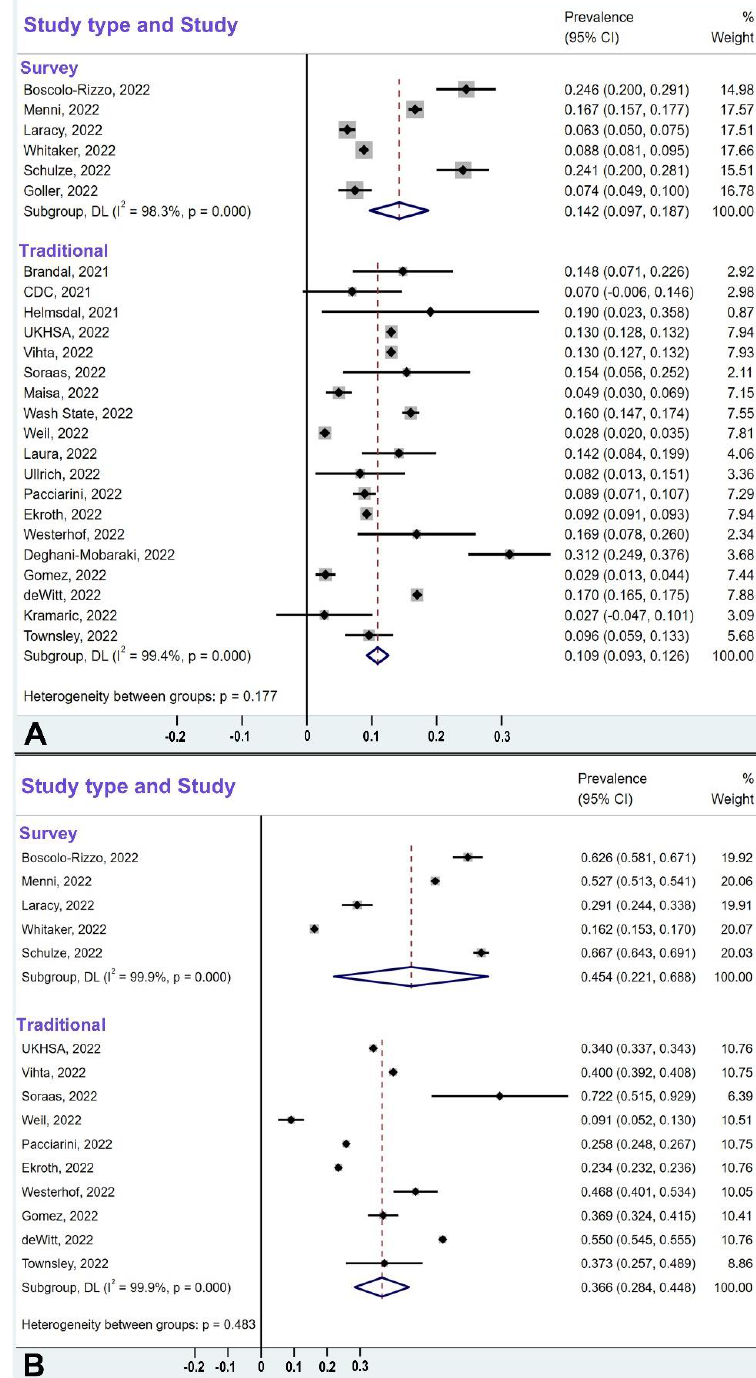
Figure 8. The pooled prevalence levels of olfactory dysfunction due to omicron ( A ) and due to other variants ( B ) in survey-type studies and traditional-design studies for populations of European ancestry. While the pooled estimates are higher in the survey-type studies than in the traditional- design studies, namely, 14.2% vs. 10.9% for omicron studies ( A ) and 45.4% vs. 36.6% for previous variants ( B ), meta-regression showed no heterogeneity between the two study types. Confidence intervals for omicron studies ( A ) were 9.7–18.7% for survey-type studies and 9.3–12.6% for traditional design studies. Confidence intervals for studies on previous virus variants ( B ) were 22.1–68.8% for survey-type studies and 28.4–44.8% for traditional design